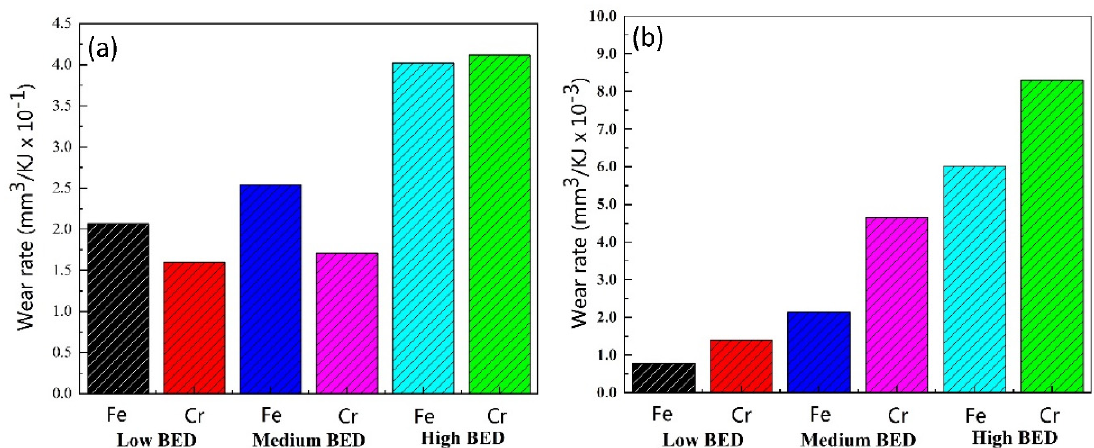
Figure 17. The wear rate of Cu–BCs and its counterpart: ( a ) wear rate of Cu–BCs and ( b ) wear rate of counterpart.